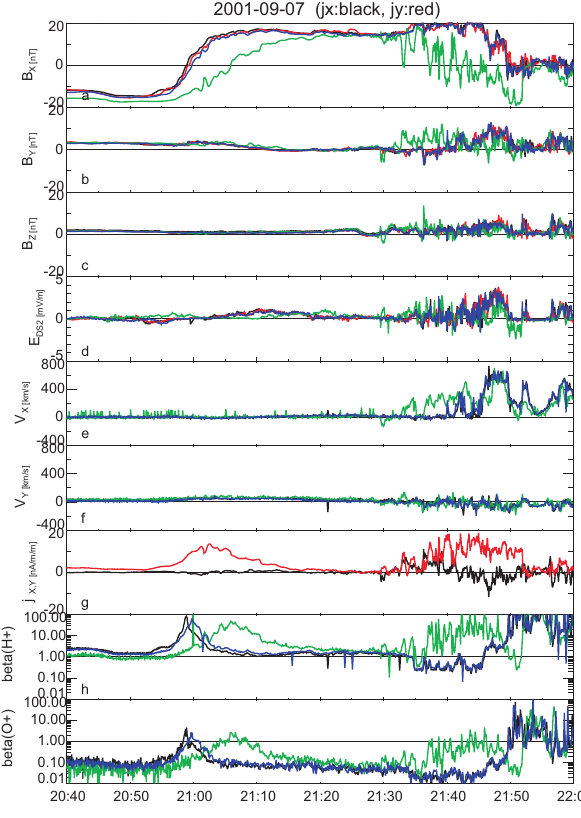
Fig. 8. (a, b, c) : spin resolution data from GSM components of the magnetic field, (d) DS2 component of the electric field, (e, f) GSM X,Y components of the proton bulk velocity, (g) current den- sity determined from the magnetic field, (h, i) proton and oxygen beta. For the particle and field plots, profiles for Cluster 1, 2, 3, 4 are plotted with black, red, green, and blue lines, respectively. Black and red lines in the current density plots correspond to X and Y components.